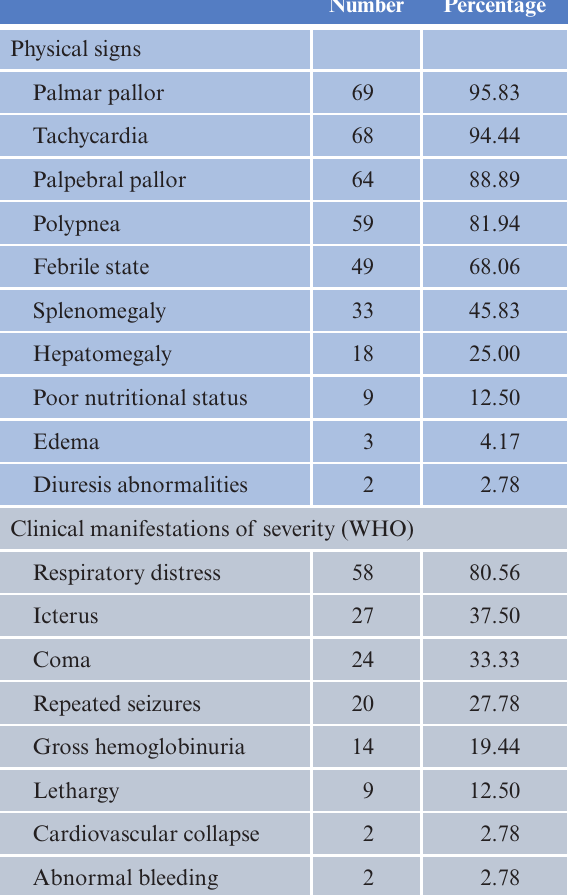
Table 3: Distribution of children with severe malaria and kidney damage according to the results of the physical examination and clinical manifestations of severity according to WHO at the Borgou DTH in 2021 (n =